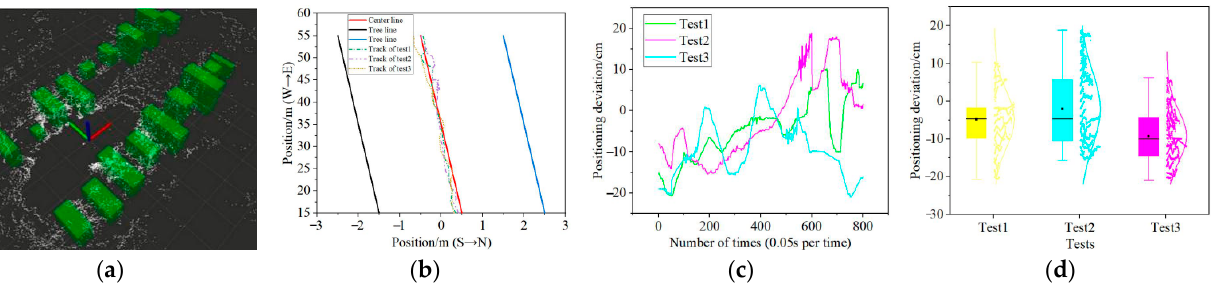
Figure 16. Positioning results. ( a ) Fruit tree positioning; ( b ) PVSR track; ( c ) LD; ( d ) probability box diagram.